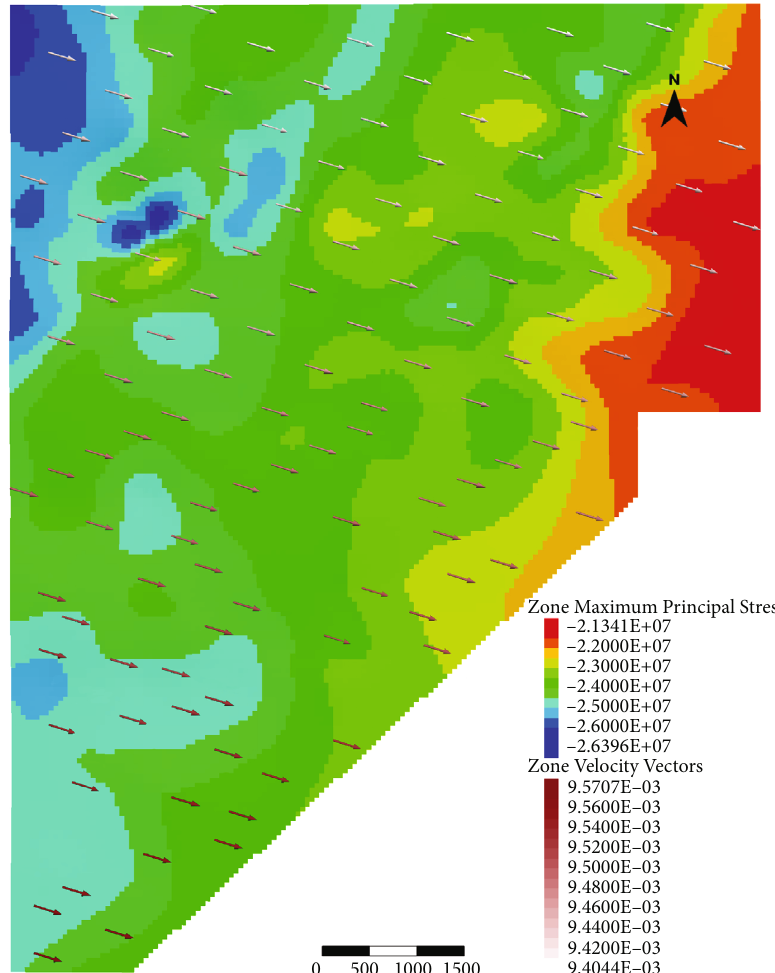
Figure 7: Isogram of maximum principal stress and moving velocity of the key stratum after loading tectonic stress (Pa,